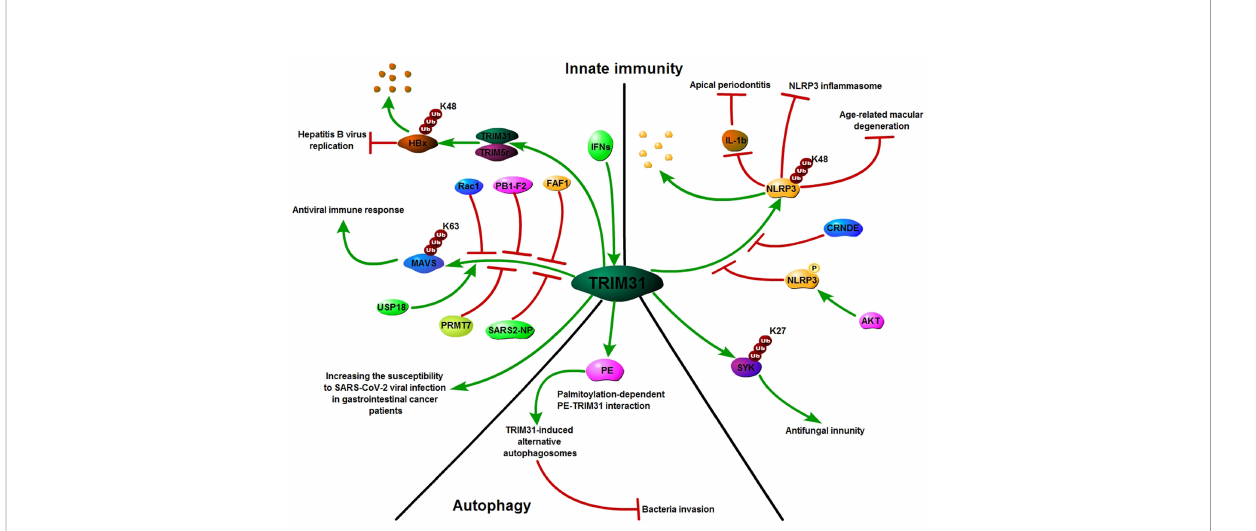
FIGURE 4 TRIM31: Growing in fl uence in innate immunity and autophagy. TRIM31 plays an important role in innate immunity; TRIM31 interacts with MAVS and catalyzes the Lys63 (K63)-linked polyubiquitination of MAVS to promote the formation of prion-like MAVS aggregates after viral infection. USP18 promotes TRIM31-mediated K63-linked MAVS polyubiquitination, while PB1-F2, Rac1, PRMT7, SARS2-NP and FAF1 inhibit TRIM31- mediated K63-linked MAVS polyubiquitination. TRIM31 directly binds to NLRP3 and promotes K48-linked polyubiquitination and proteasomal degradation of NLRP3. AKT and CRNDE decreased TRIM31-mediated NLRP3 ubiquitination. Alongside its emerging role in innate immunity, TRIM31 is also known to be involved in